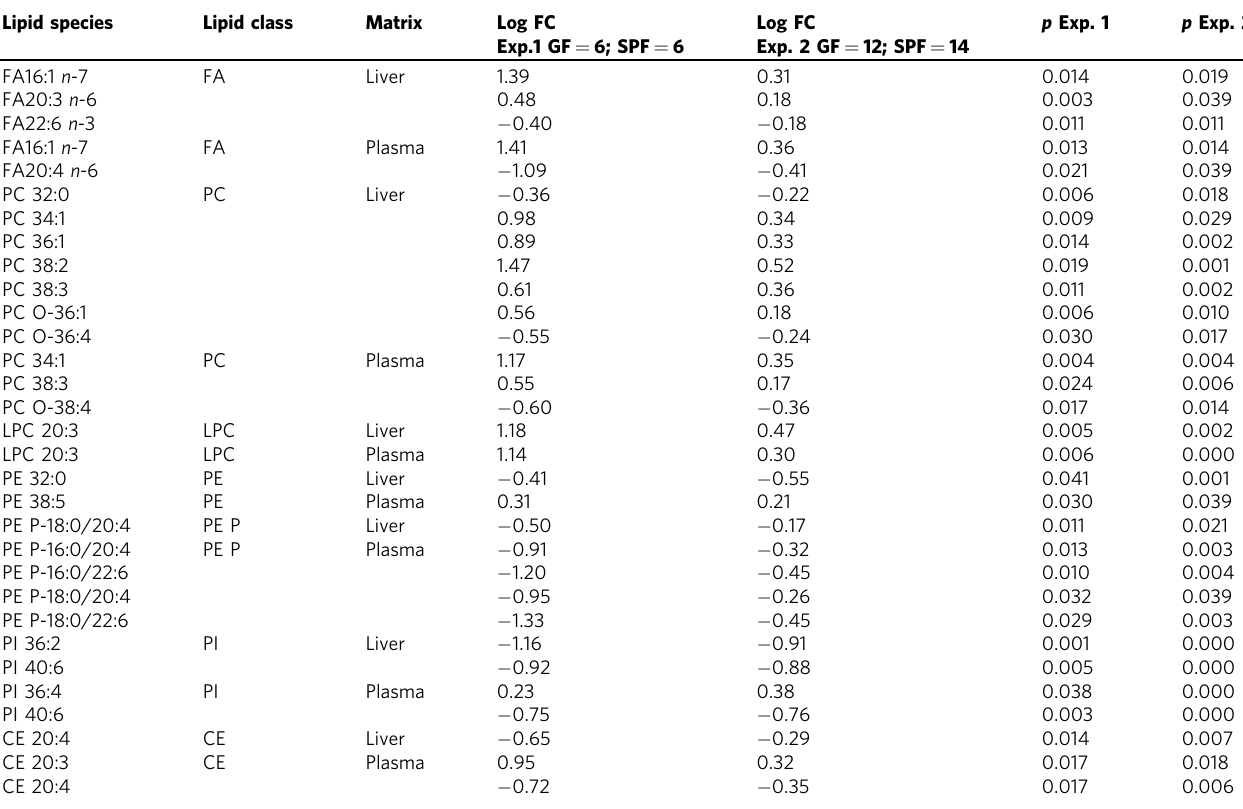
Table 2 Veri fi ed lipid species that signi fi cantly differ in plasma and liver samples between GF and SPF mice Lipid species Lipid class